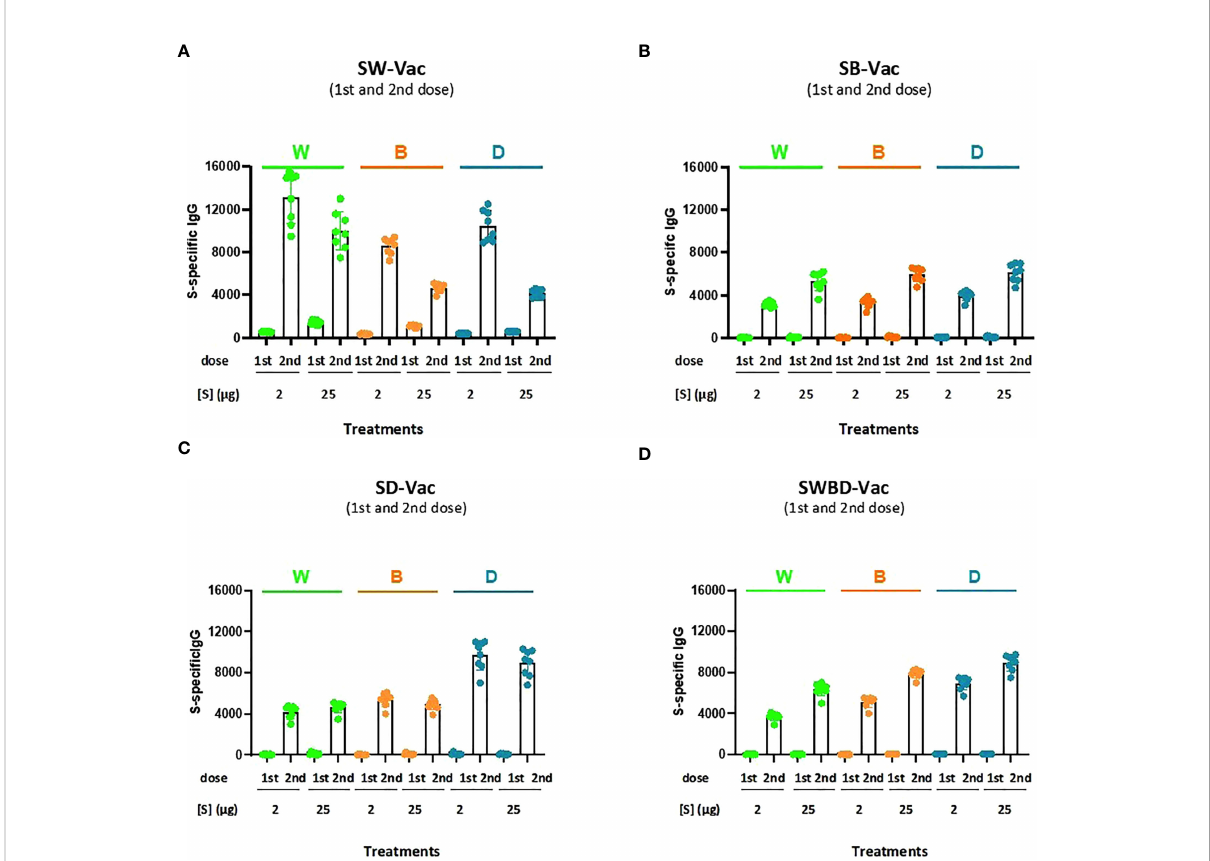
FIGURE 3 Anti-spike IgG titers induced by S-Vac formulations in mice. BALB/c mice (n=8/group) were immunized on Days 0 and 14 with formulations containing spike puri fi ed protein from ancestral Wuhan (A) , Beta (SB, B ), Delta (SD, C ) or a combination of spike protein from W, B and D SARS- CoV-2 variants (SWBD, D ) in 2 different concentrations- 2 and 25 µg delivered intramuscularly. Serum collected on Day 14 was analyzed by ELISA to determine the levels of S-speci fi c IgG. The IgG speci fi city of the sera was indicated in the top of the fi gures. Sera titers were obtained by plotting the OD 492 nm vs. log curve of the reciprocal of the dilution in the GraphPad Prism program. Titers are expressed as the inverse of the in fl ection point dilution of the curve. For statistical analysis, antibody titers were log-transformed and then analyzed by a one-way ANOVA with Bonferroni ’ s multiple comparisons test. For all treatments, the titers detected after the second dose were signi fi cantly different from those found after the fi rst dose